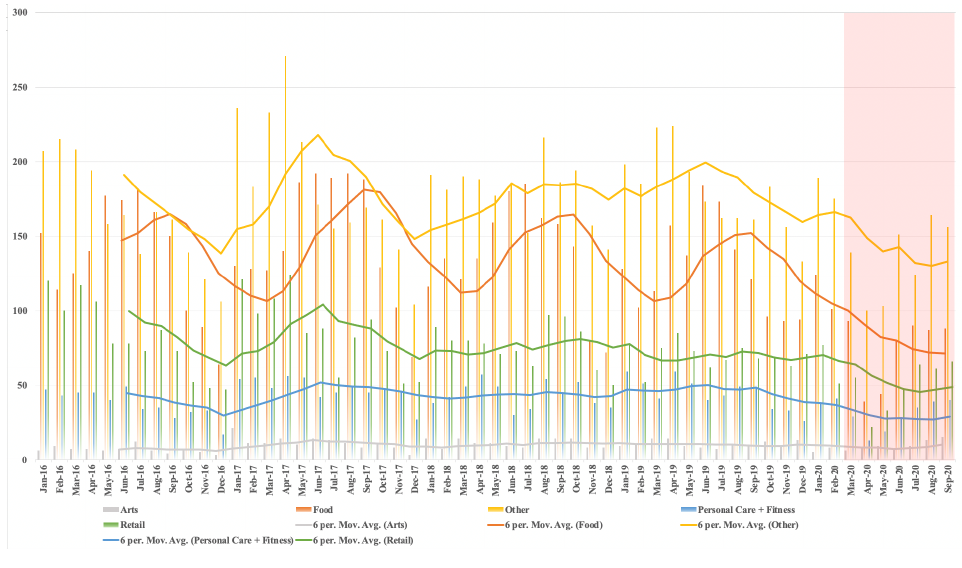
Figure 4: Monthly new starts by business type from January 2016 – September 2020